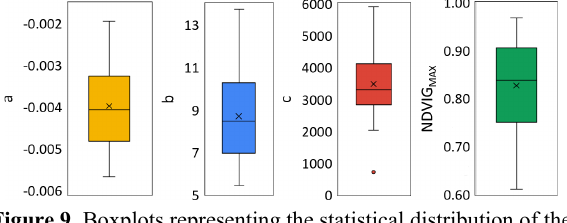
Figure 9 . Boxplots representing the statistical distribution of the three GDD_0-based model coefficients ( a, b, c ) and the NDVIG MAX predicted by the model . From bottom-up: 5 th , 25 th , 50 th , 75 th and 95 th percentiles. Cross is the mean value. Dots are outliers. All coefficients are multiplied by 10000.